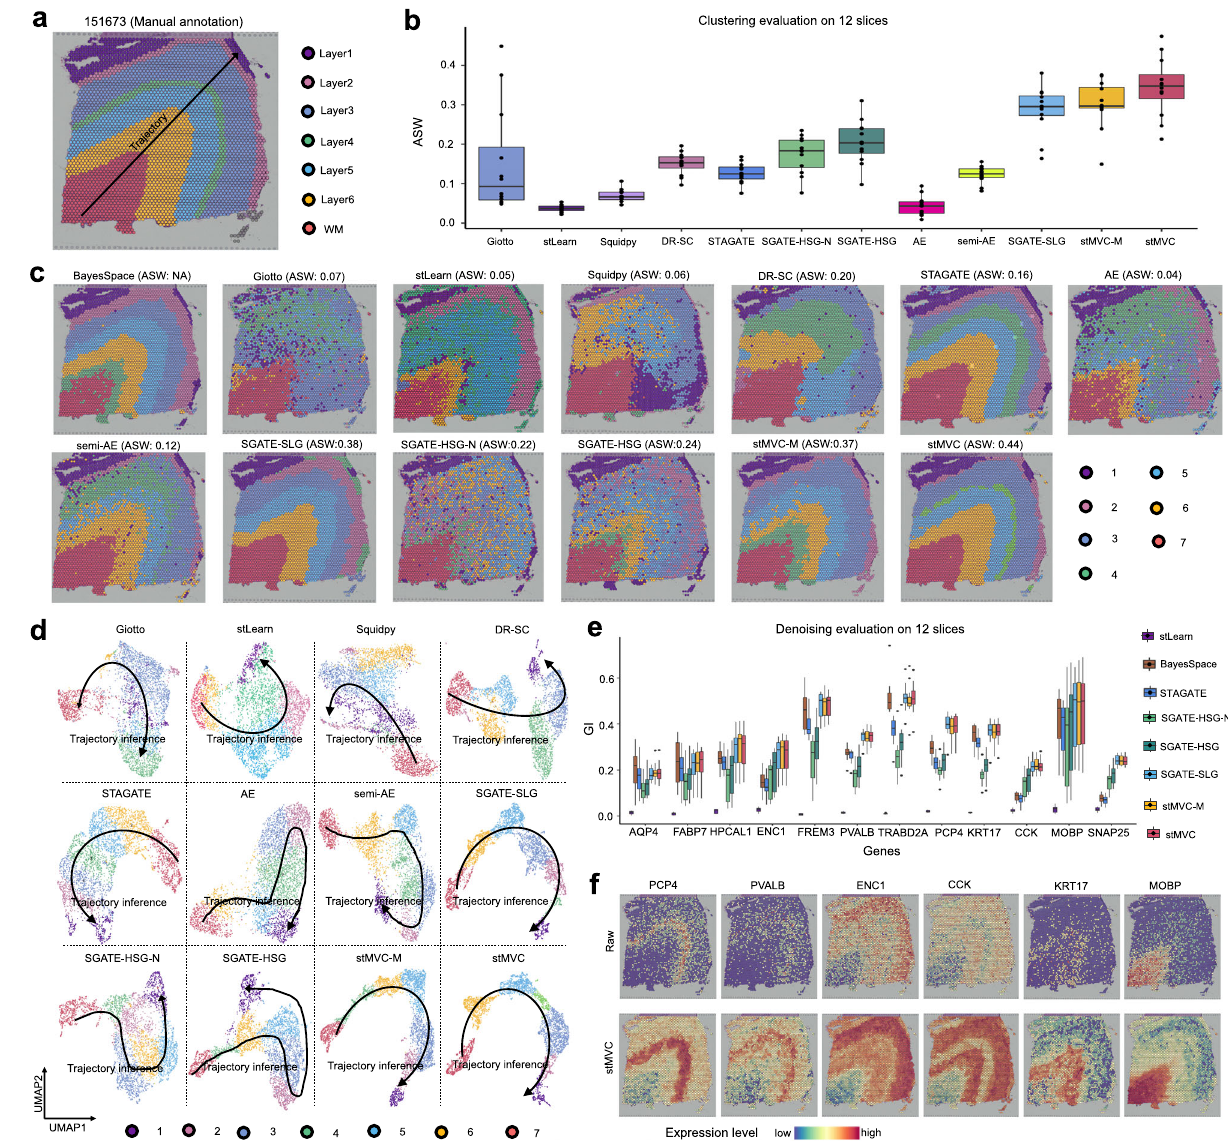
Fig. 2 | stMVC is able to detect spatial domains, visualize the relationship distance between different domains, and denoise data on the DLPFC dataset. a Annotation ofseven DLPFClayersinslice 151673 by the previous study 26 , and the spatialadjacencyandchronologicalorderbetweentheselayersareWM → Layer6 → Layer5 → Layer4 → Layer3 → Layer2 → Layer1. b Boxplot of clustering accuracy in terms of average silhouette width (ASW) for assessing the closeness of multi-view jointfeaturesofsameclustercomparedto theotherclusters,onall n =12samples. In the boxplot, the center line, box limits and whiskers separately indicate the median, upper and lower quartiles and 1.5 × interquartile range. c Spatial domains detected by BayesSpace, Giotto, stLearn, Squidpy, DR-SC, STAGATE, AE, semi-AE, the three SGATE-based single-view models, stMVC-M, and stMVC on slice 151673. d Scatter plot of the two-dimensional UMAP extracted from the latent features by Giotto,stLearn,Squidpy,DR-SC,STAGATE,AE,semi-AE,threeSGATE-based single-